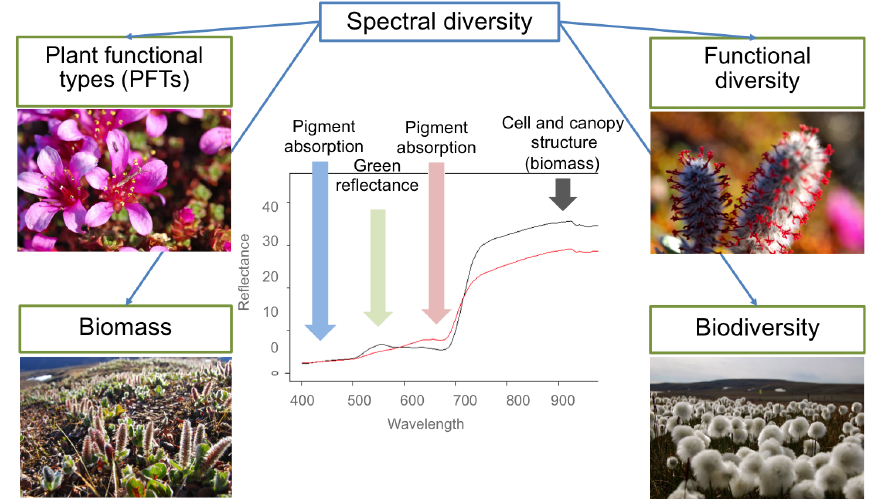
Figure 20. Spectral characterization of key biophysical and biochemical variables can inform the interpretation of airborne and satellite hyperspectral remote